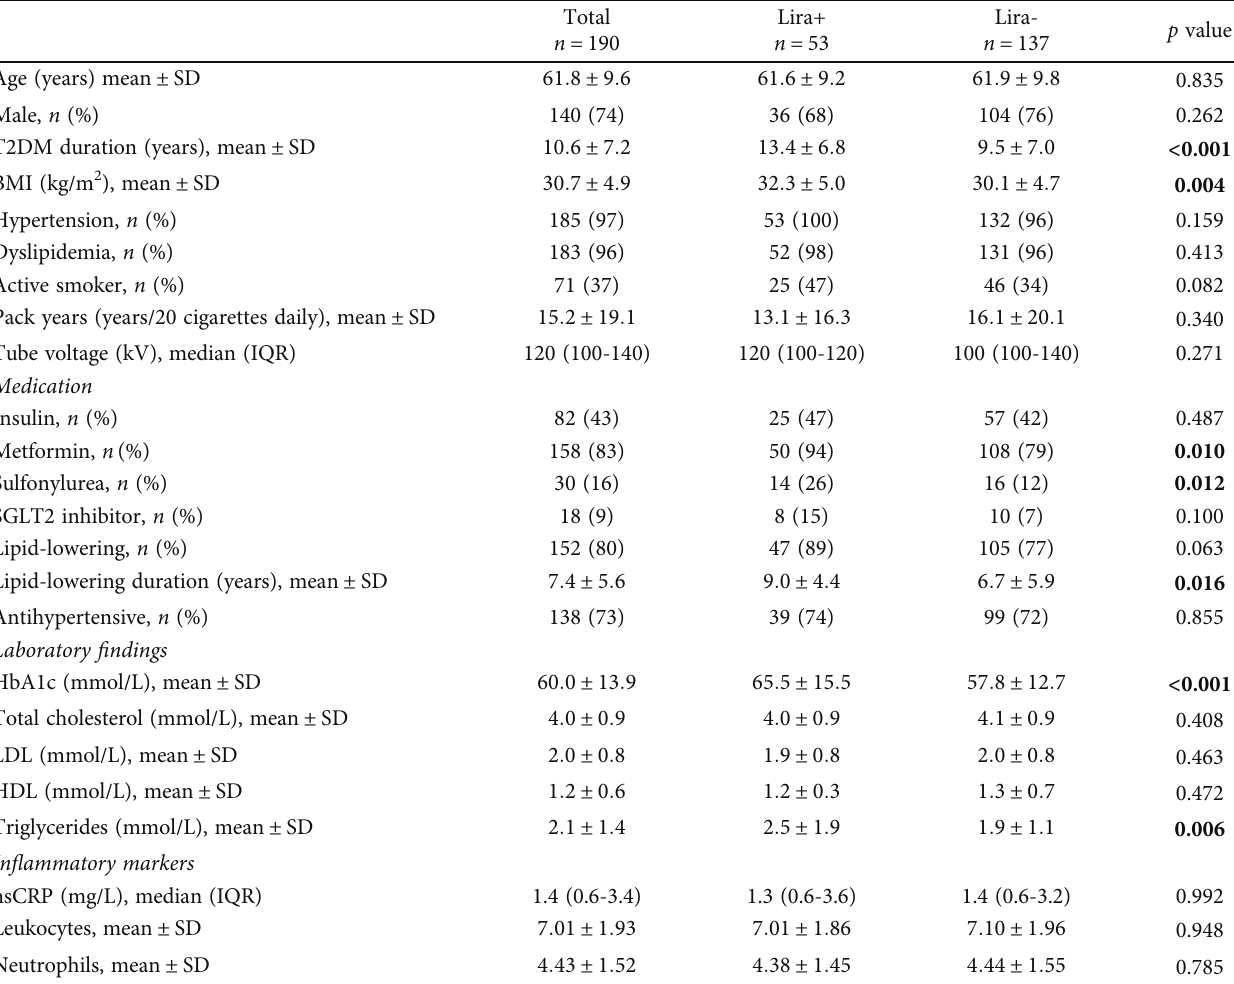
Table 1: Baseline characteristics of T2DM patients, total and strati fi ed by liraglutide